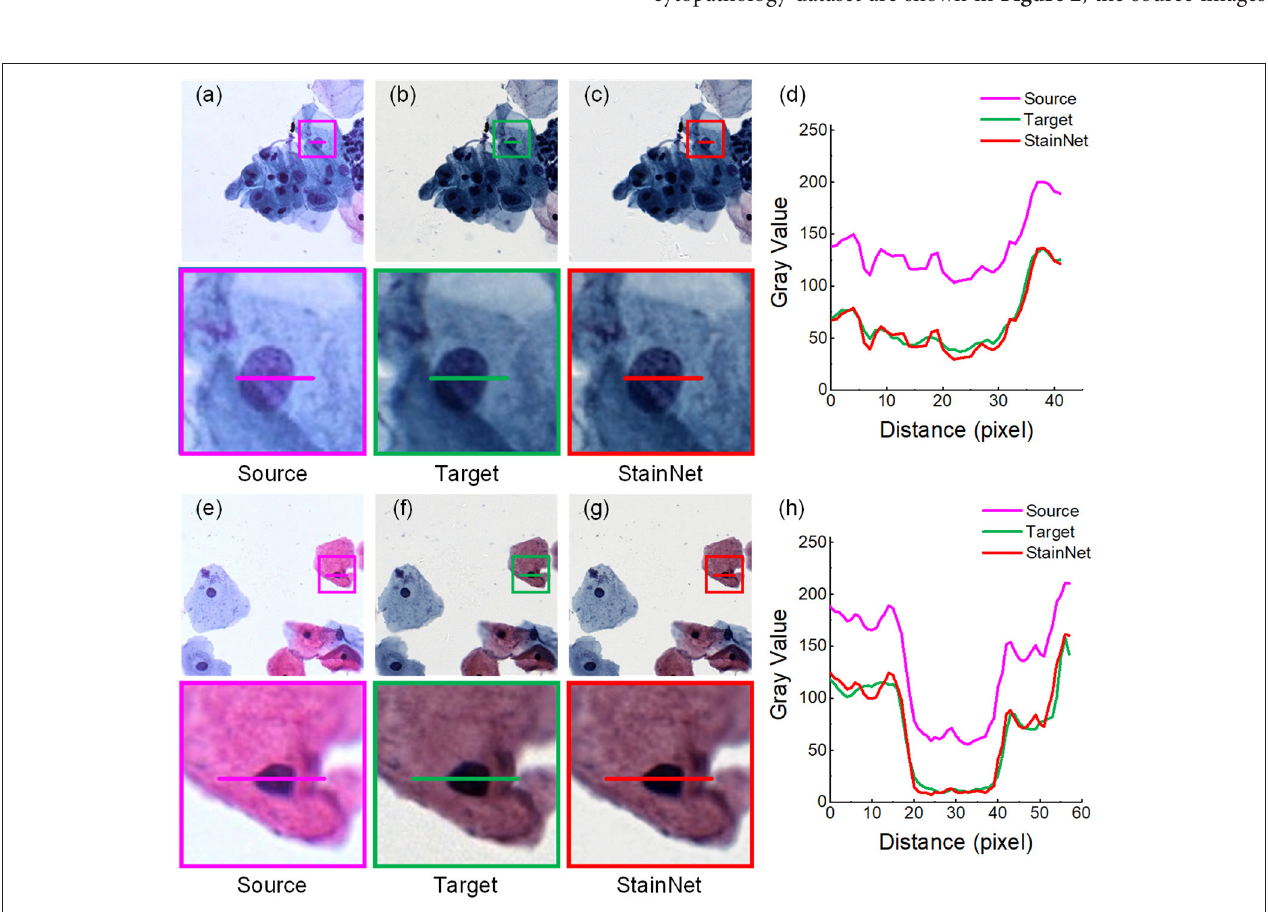
FIGURE 2 | StainNet normalization effects on the cytopathology image. The source images, the target images, and the normalized images by StainNet are shown in (a,e) , (b,f) , and (c,g) , respectively. The image in the box is enlarged below. Gray value profiles of the lines on (a–c) are shown in the line chart (d) , and the lines in (e–g) are shown in the line chart (h)